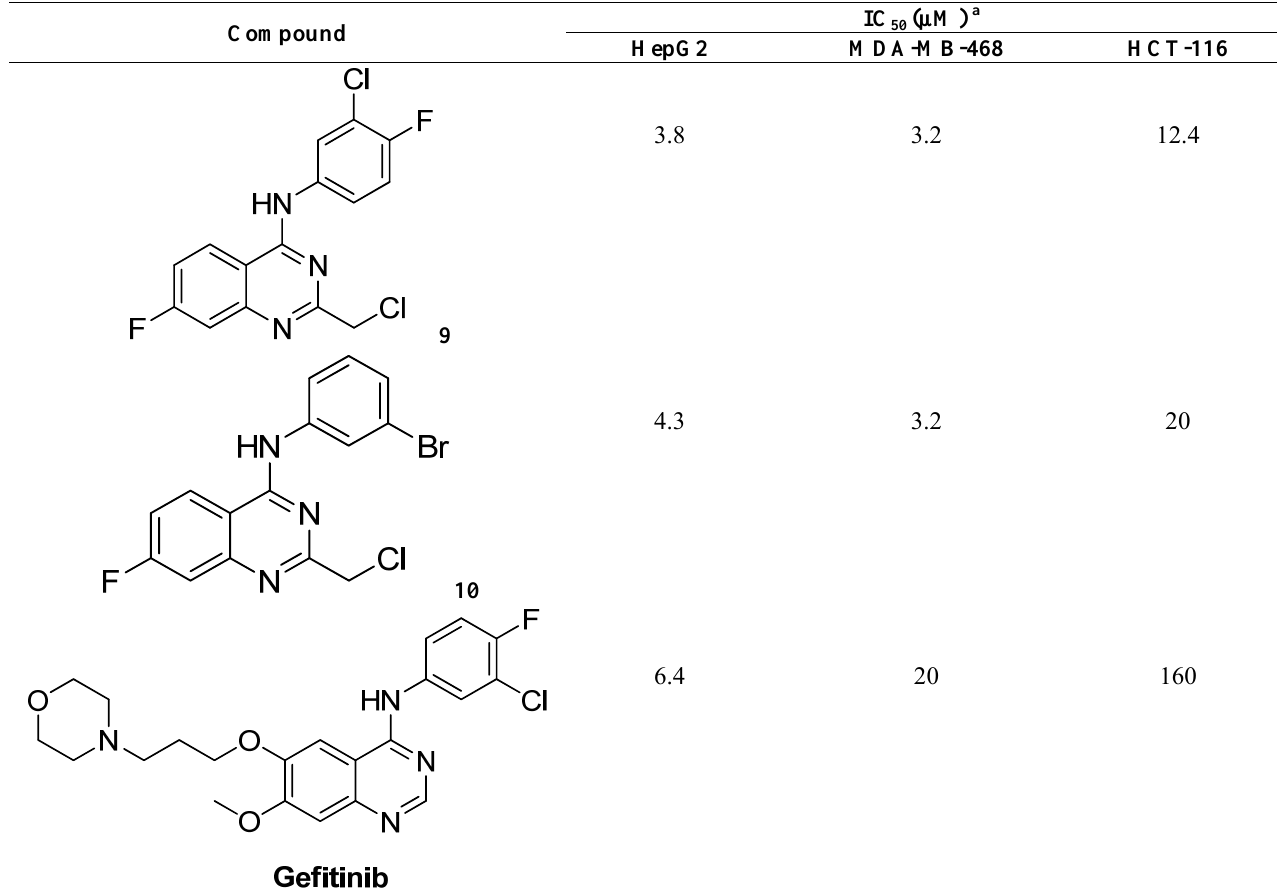
Table 3. The anti-proliferative activities of compounds 9 and 10 against various cancer cell